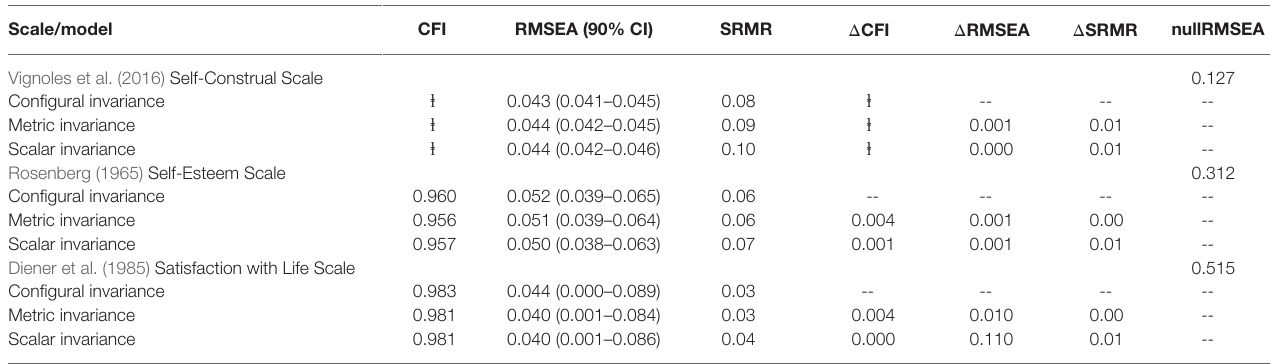
TABLE 6 | Tests of measurement invariance for the scales in Study 2. Scale/model Vignoles et al. (2016) Self-Construal